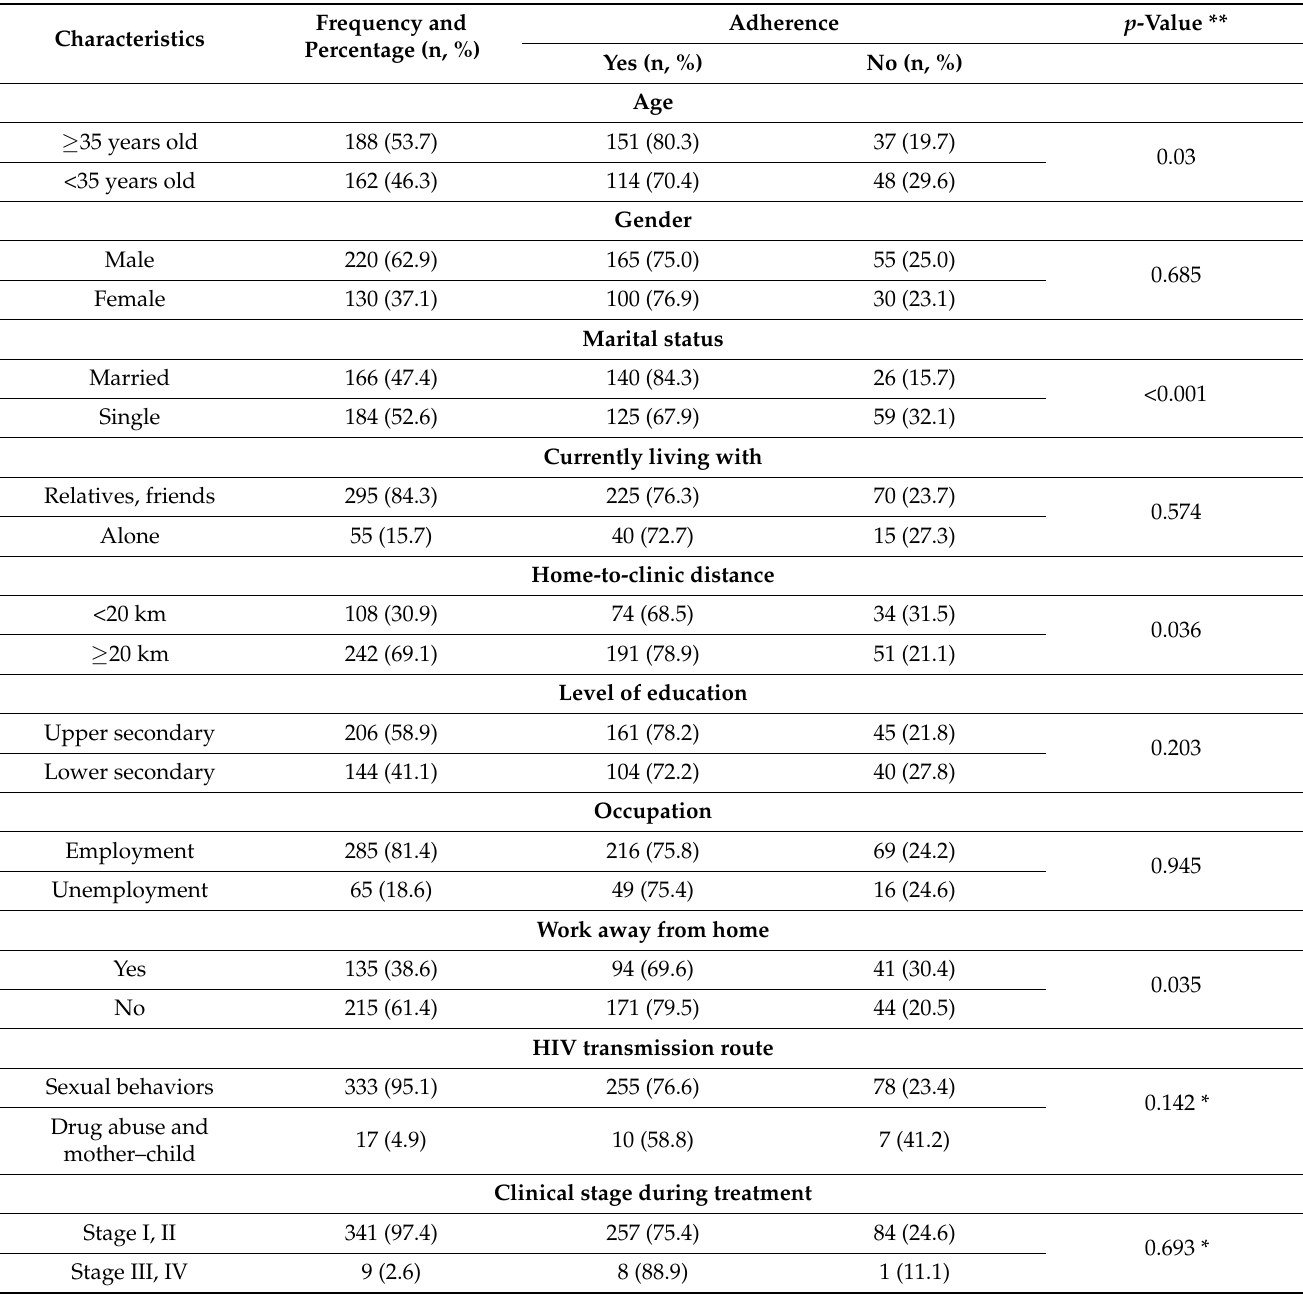
Table 1. Study population